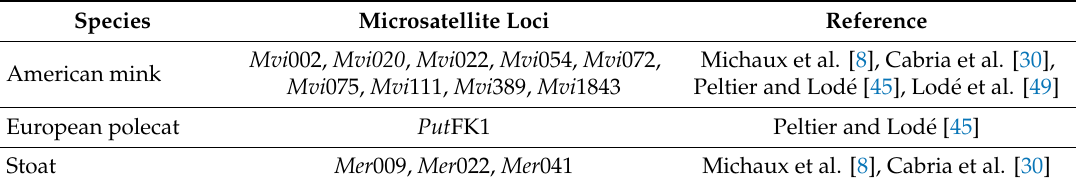
Table 2. Microsatellite loci identified for M. lutreola by Cabria et al. [9].